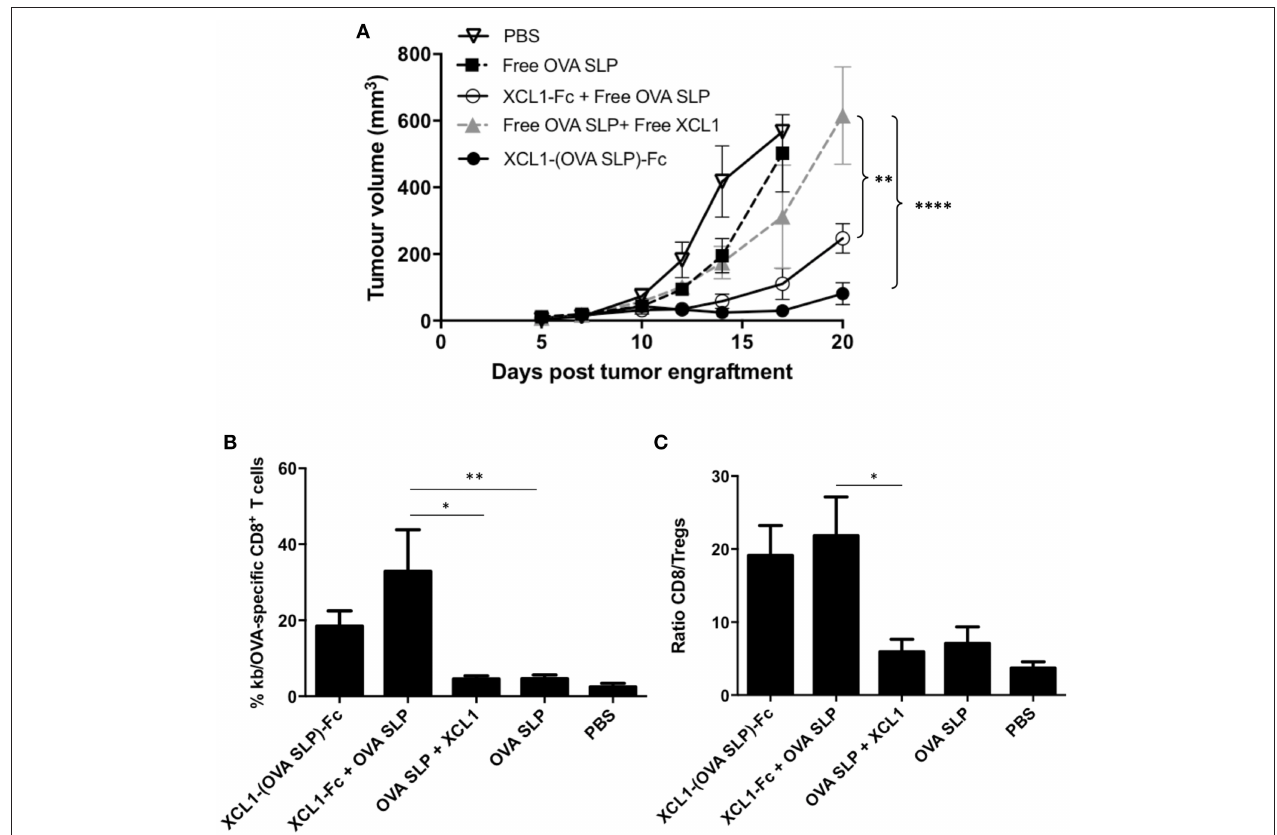
FIGURE 5 | Effective therapeutic vaccinations with Xcl1-(OVA SLP) fusion proteins even in the absence of OT-1T cell transfer. (A) B16.OVA tumor growth of C57BL/6 mice engrafted subcutaneously on the left flank with of 2 x 10 5 B16.OVA cells followed by intradermal vaccination on day 3. Data is shown as mean ± SEM ( n = 5–6 mice/group). Results are representative of three independent experiments. (B) Frequencies of SIINFEKL-specific CD8 + T cells present in the B16.OVA tumors harvested 10 days post vaccination. (C) Ratio of SIINFEKL-specific CD8 + T cells vs. Tregs within B16.OVA tumors. Data is shown as mean ± SEM ( n = 5–6 mice/group). Results are representative of two independent experiments. * p < 0.05, ** p < 0.01, **** p <